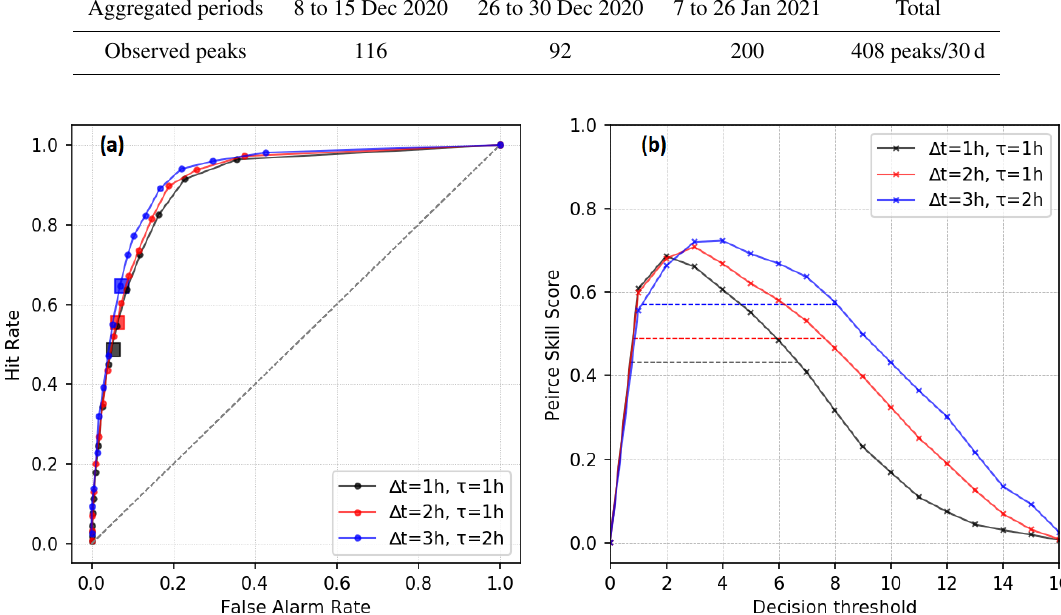
Table 5. Aggregated time periods for calculating the probabilistic scores of evaluation of pX ensemble and deterministic simulations.